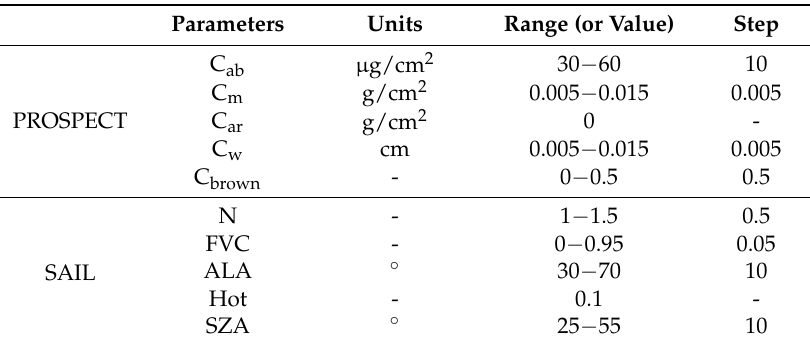
Table 1. Input parameters in the PROSAIL